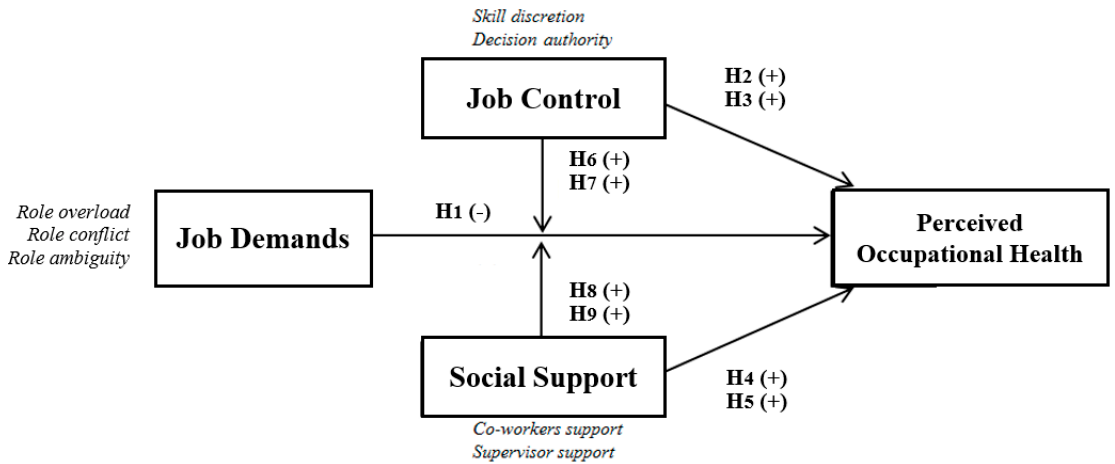
Figure 2. Model Figure 2. Model hypotheses.